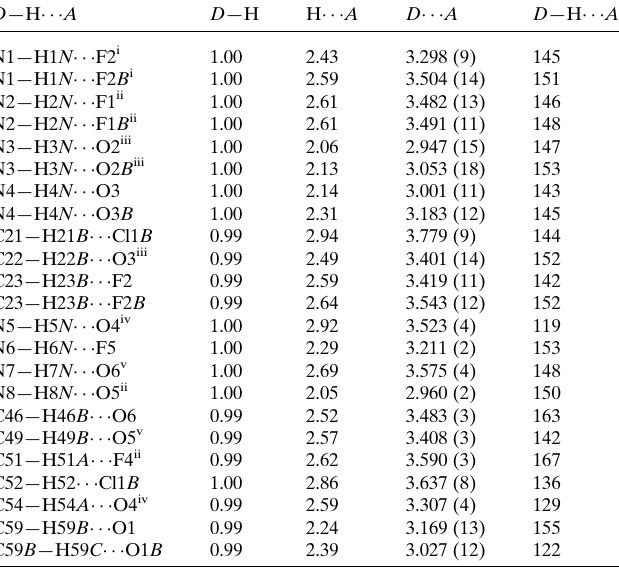
Table 4 Hydrogen-bond geometry (A˚ , (cid:3) ) for 2